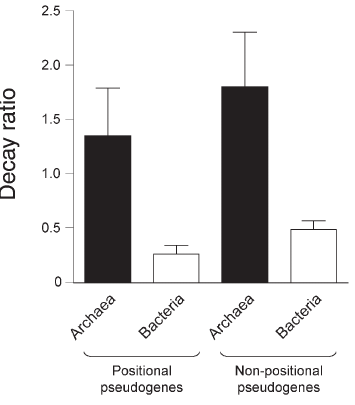
Figure 3. Differences in the gene decay ratios (calculated as the ratio of pseudogenes eroded by multiple inactivating mutations to pseudo- genes inactivated by a single mutation) for archaeal (filled bars) and bacterial (open bars) pseudogenes.